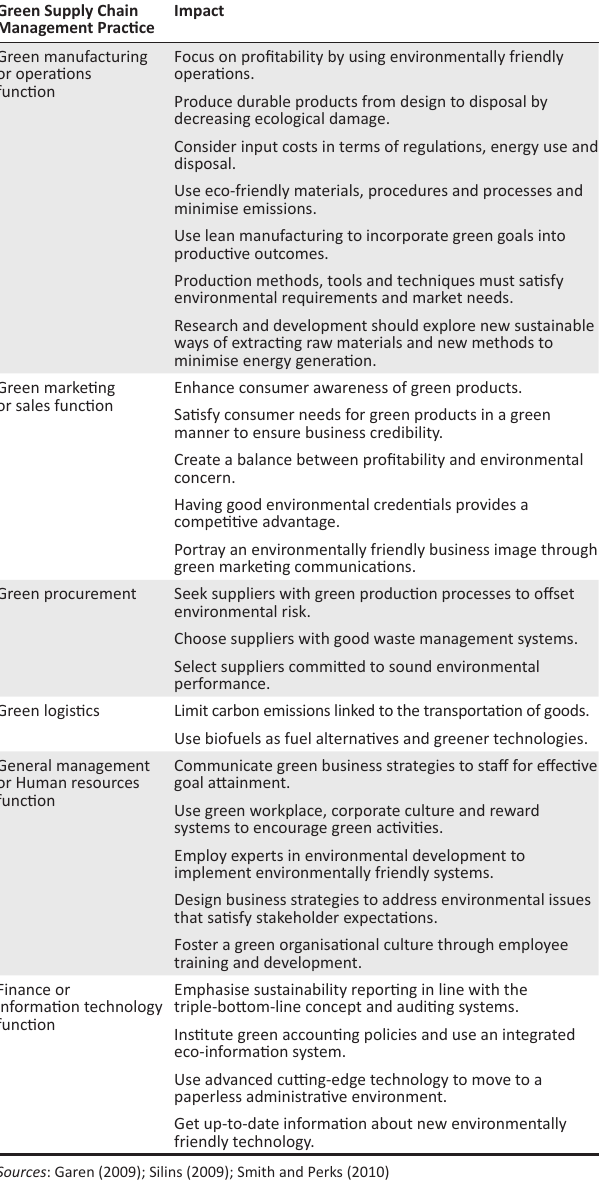
TABLE 1: The implications of green supply chain management on business functions. Green Supply Chain Management Practice Green manufacturing or operations